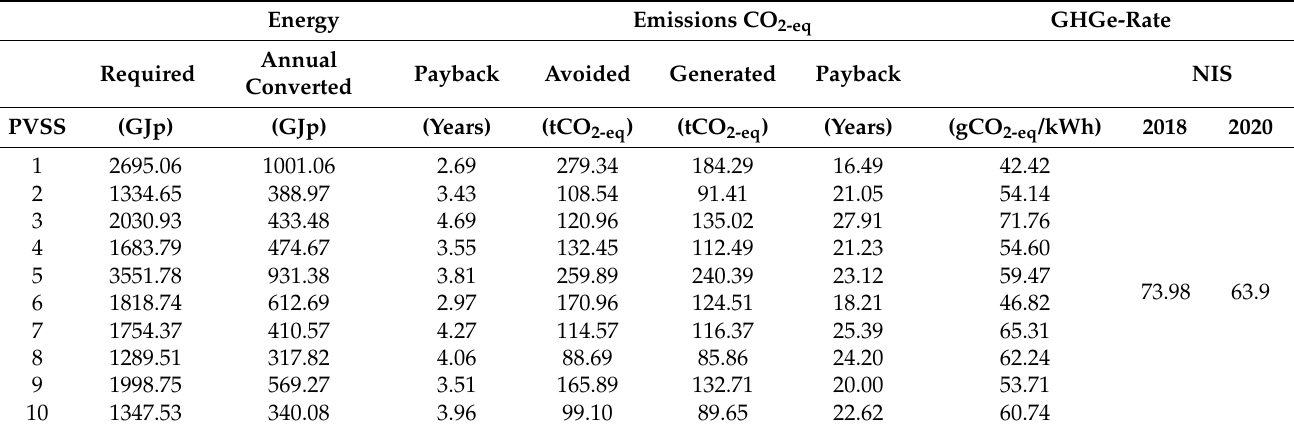
Table 3. Energy payback time and GHGe-rate for the solar PV power plants. Energy Emissions CO 2-eq